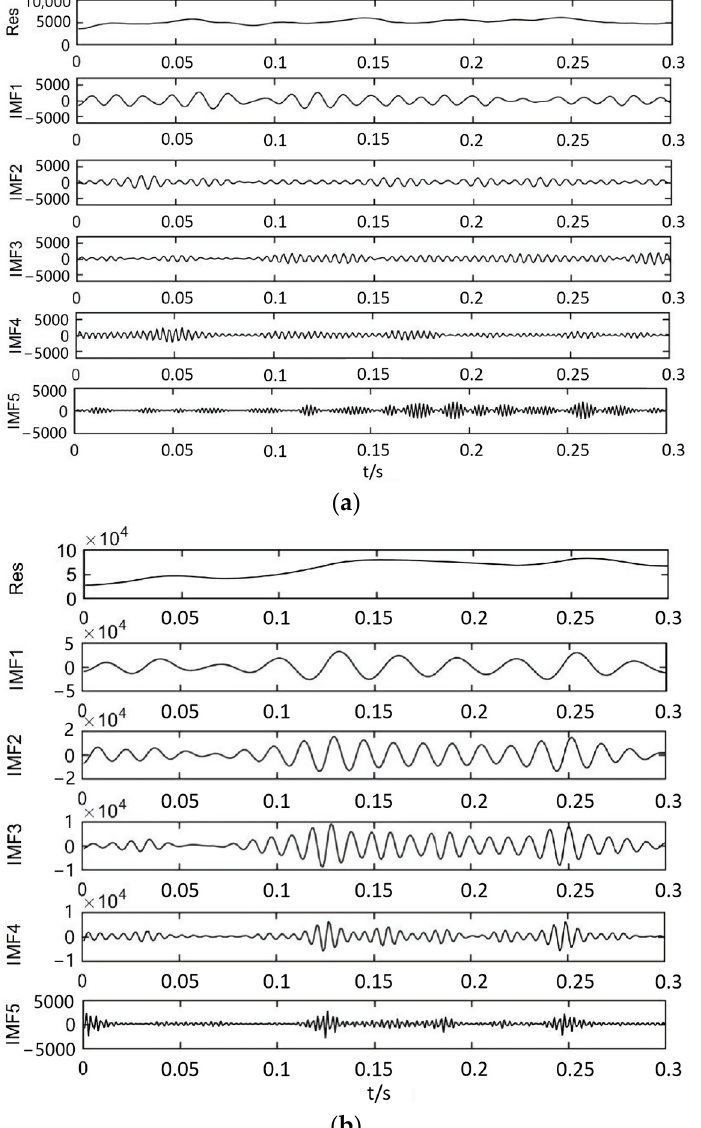
Figure 5. The VMD decomposition waveform of a submarine cable vibration signal. ( a ) Scouring vibration signal decomposition; ( b ) anchor smash vibration signal decomposition.